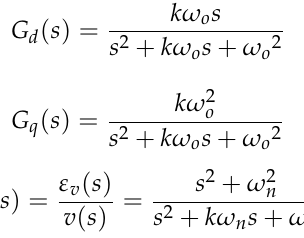
d ( s ) and ( b ) G q ( s